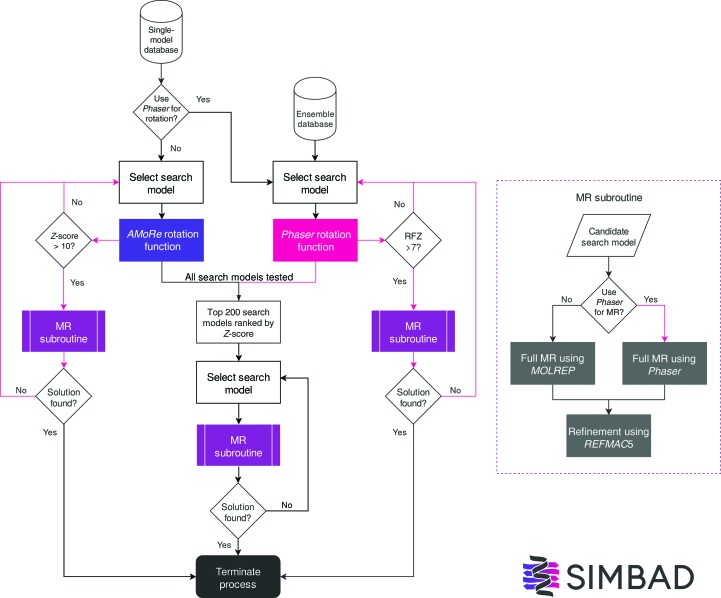
Flowchart detailing the new Phaser pathways (shown with pink arrows) that have been implemented in SIMBAD. Criteria for a solution are R values of <0.45 from REFMAC5 and/or an LLG of >60 and TFZ of >8 if MR is performed using Phaser. SIMBAD will use the MR subroutine to test the top 200 solutions ranked by AMoRe
Z-score or Phaser RFZ score unless a solution has been identified by the early-termination procedure. The early-termination procedure is triggered when a search model achieves a Z-score of >10 in an AMoRe search or an RFZ of >7 in a Phaser search. This search model is tested using the MR subroutine and if the placed model meets the criteria for a solution then the process will terminate early.